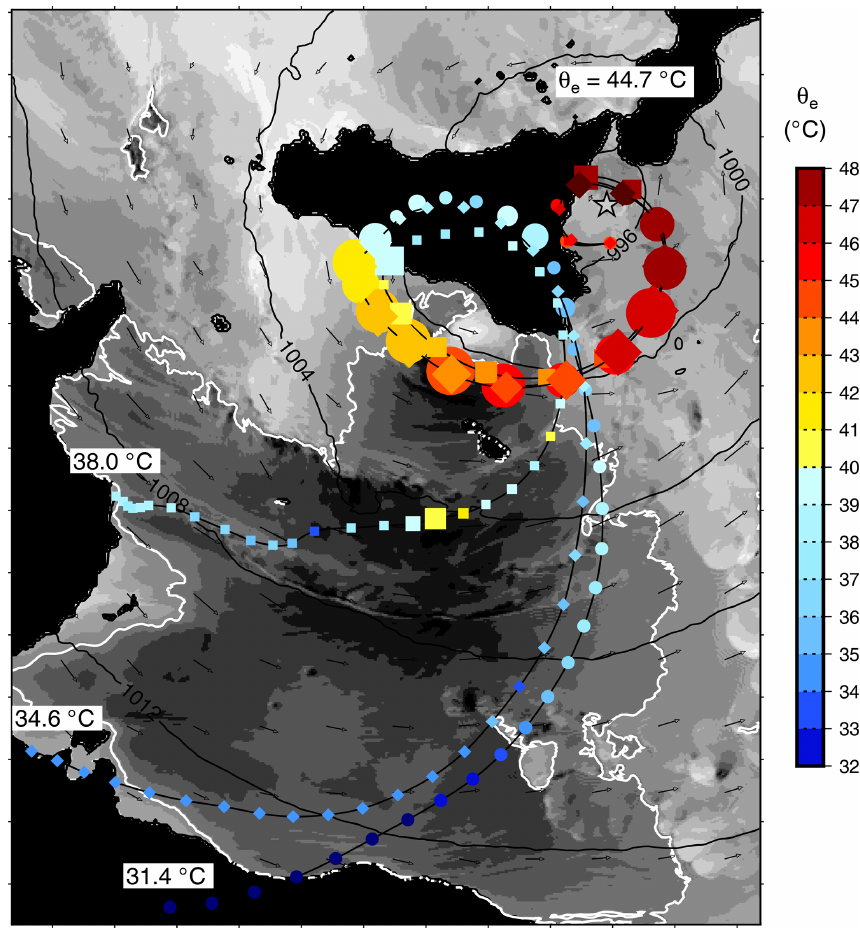
Figure 17. Map of the back trajectories of air parcels arriving south of the cyclone centre at 23:00UTC on 7 November, 1500ma.s.l., at three different levels (circles, squares and diamonds). The first point of the trajectories corresponds to the start of the D2 domain simulation (00:00UTC on 7 November). The colour scale indicates the equivalent potential temperature ( ◦ C), and the size of the symbol is inversely proportional to altitude between 0 and 1000m and constant above 1000m. Also shown are the values of the final equivalent potential temperature and of the initial equivalent potential temperatures, the wind field at 900hPa (black vectors), and the surface enthalpy flux (grey shades) with a threshold at 600Wm − 2 (white contour) at 15:30UTC, when the particles arrive at sea to the south of